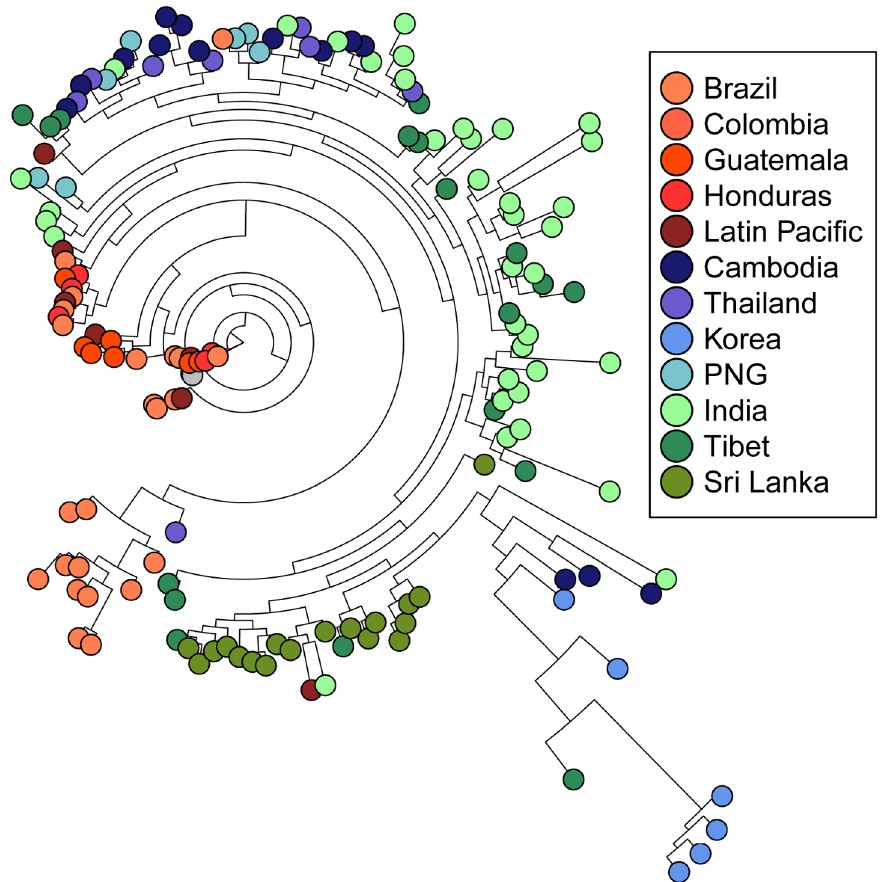
Figure 7. Neighbor-joining tree of pvcsp VK210 repeat arrays. All unique repeat array haplotypes from each pvcsp VK210 population set were plotted on a single unrooted, neighbor-joining phylogenetic tree. Visual inspection reveals strong geographic clustering by region and country. Latin American sequences are in shades of red, South East Asian sequences are in shades of blue, and South and Central Asian sequences are in shades of green.